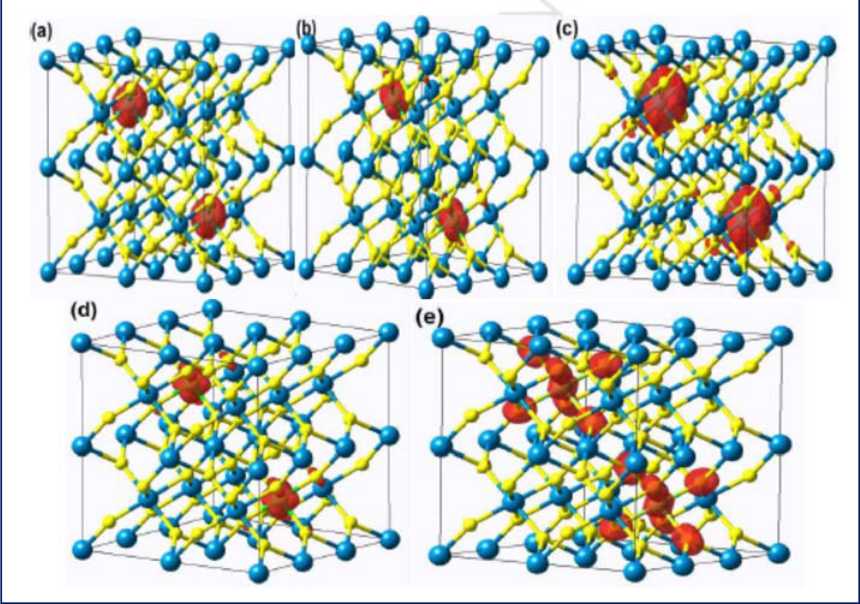
Figure 4. Comparative diagram for local magnetization density for ( a ) Mn, ( b ) Fe, ( c ) Cr, ( d ) Co and ( e ) Zn doped SnO 2 (The Figure is reproduced by copyright permission from reference [29]).